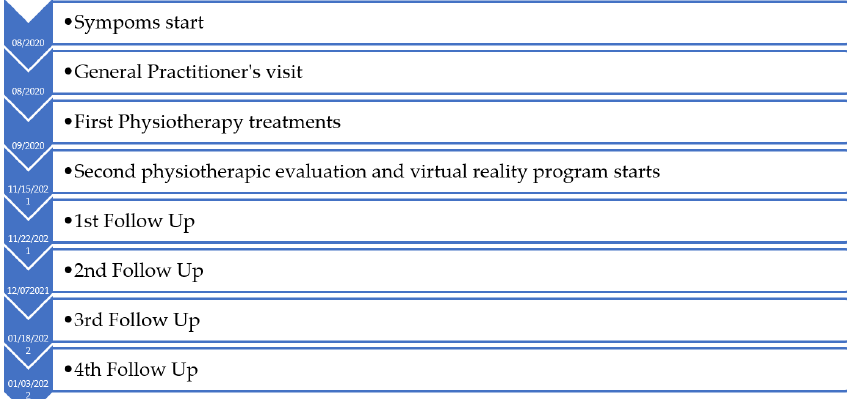
Figure 2. Timeline. Figure 2.